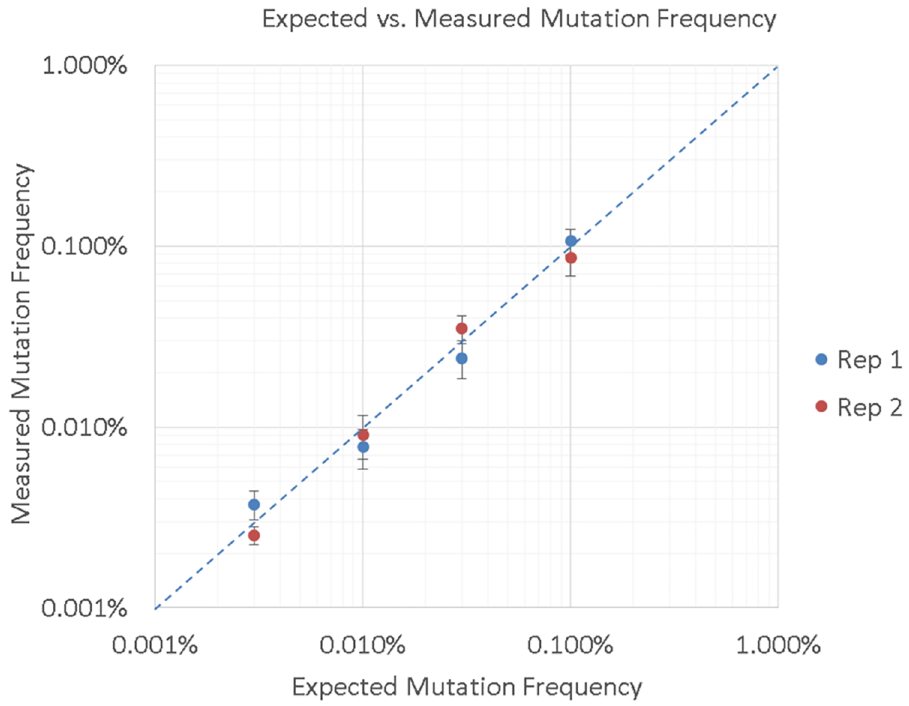
Fig 6. Expected vs. measured mutation frequency. The average measured mutation frequency across all five mutations is plotted against the average expected frequency, for two replicates. Error bars indicate the standard error of the mean at each point, while the dashed line indicates 1:1 concordance between expected and measured values. Data is shown in S3 Table.